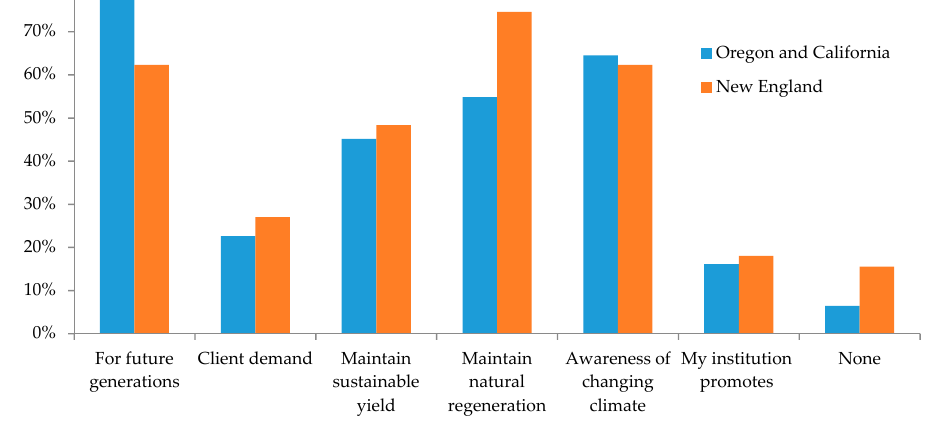
Figure 2. Motivations for managing for climate change summarized by total number of selections.